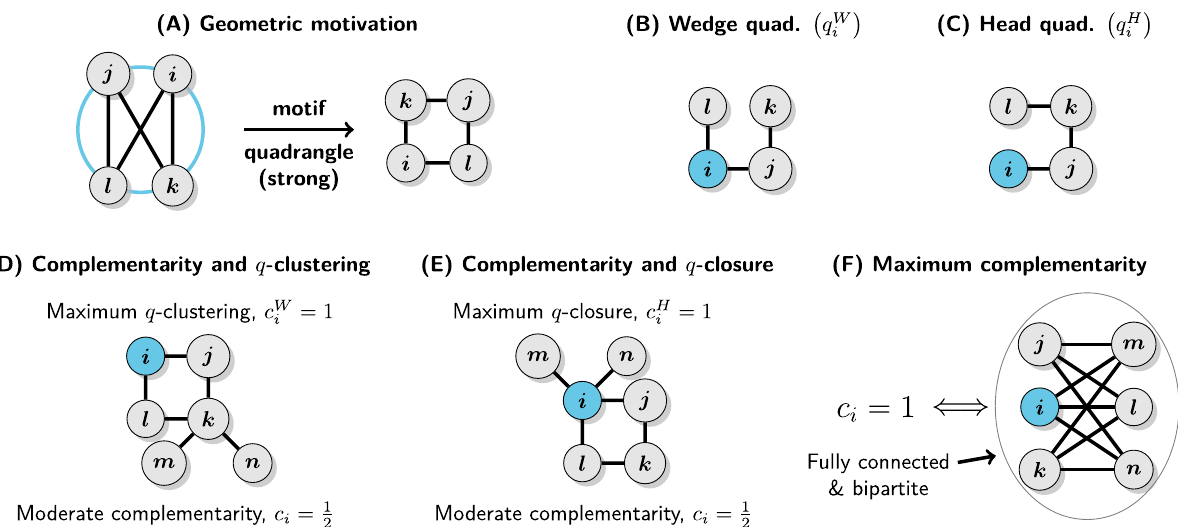
Figure 3. Geometric motivation and the main properties of structural complementarity coefficients. ( A ) On the surface of a (hyper)sphere for each point there is only a single other point at the maximum distance, so complementarity based on distance maximization must lead to the abundance of strong (chordless) quadrangles and locally dense bipartite-like subgraphs. ( B , C ) Wedge and head quadruples. ( D ) Local q -clustering can be maximized even when some 2-hop neighbors (node k on the figure) of the focal node connect to nodes which are not in N 1 ( i ) , while the c i is sensitive to this deviation from the principle of complementarity. ( E ) Local q -closure can be maximized even for nodes with sparse 1-hop neighborhoods if they are star-like as neighbors with degree one do not generate any head quadruples. ( F ) Necessary and sufficient conditions for maximum structural